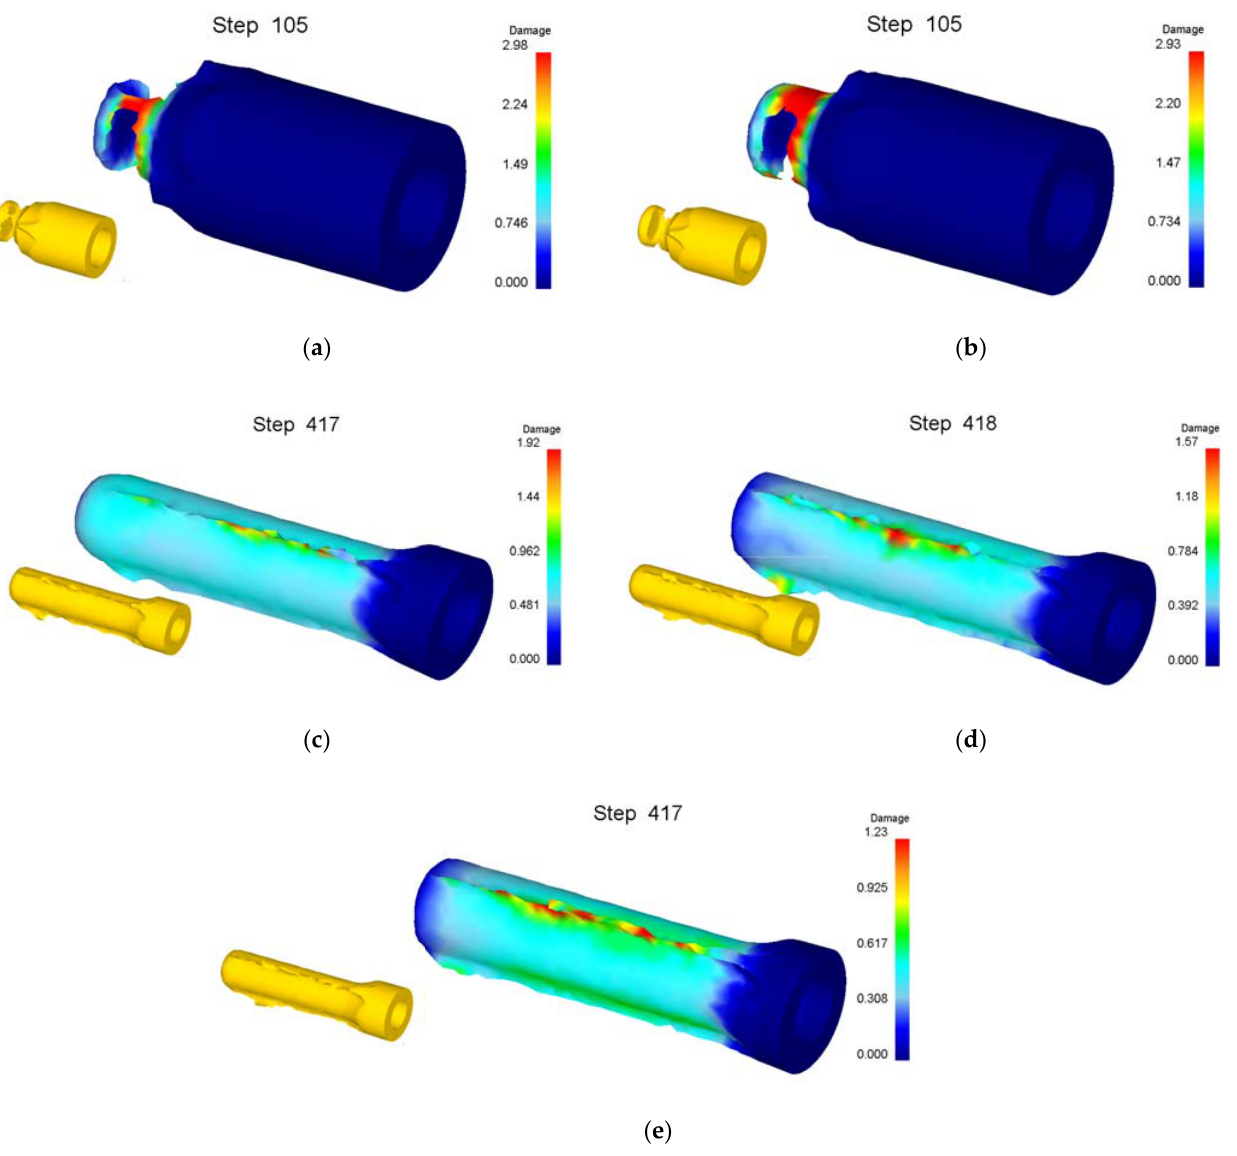
Figure 15. Damage value distribution of different punch fillet radii of ( a ) 5 mm; ( b ) 10 mm; ( c ) 15 mm; ( d ) 20 mm; ( e ) 30 mm. Table 5. Simulation results of different punch fillet radii.